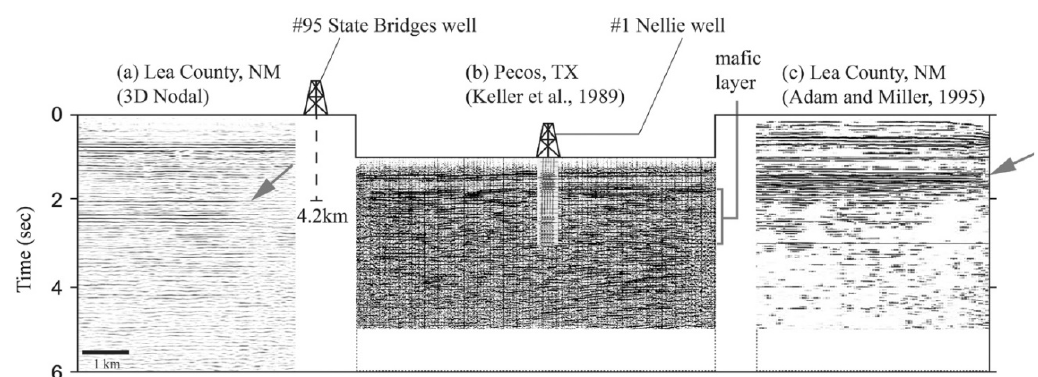
Figure 9. Layered basement reflections from the COCORP reflection profiles in western Ohio [67].